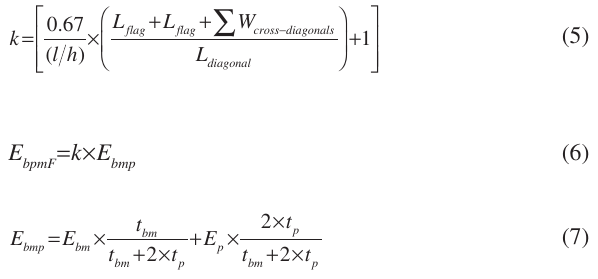
account for this effect in the numerical model, the modu- lus of elasticity of the strengthened infi ll is modifi ed. The modifi cation factor, k was a function of the frame ’ s aspect ratio and calculated using Eq. (5). The modifi ed modulus of elasticity was calculated in accordance with Eq.